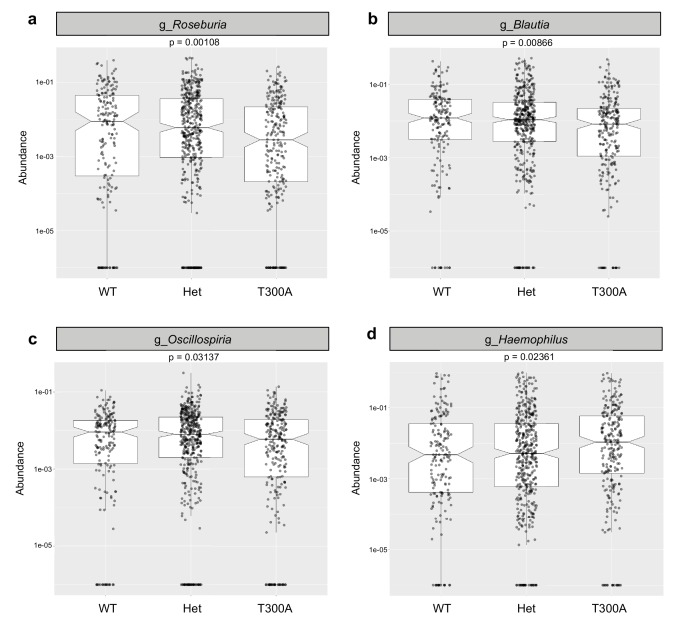
The presence of T300A in humans reduces Clostrida spp. and increases Gammaproteobacteria.16S rRNA gene amplicon data from human stool samples from Jostins et al. 2012 (Xavier and Podolsky, 2007) cohort were analyzed for differences in the microbiota associated with the presence (T300A – GG), absence (WT – AA) or heterozygous (Het – AG) genotype. (g = genus). (a) Relative abundance of Roseburia. (b) Relative abundance of Blautia. (c) Relative abundance of Oscillospira. (d) Relative abundance of Haemophilus.